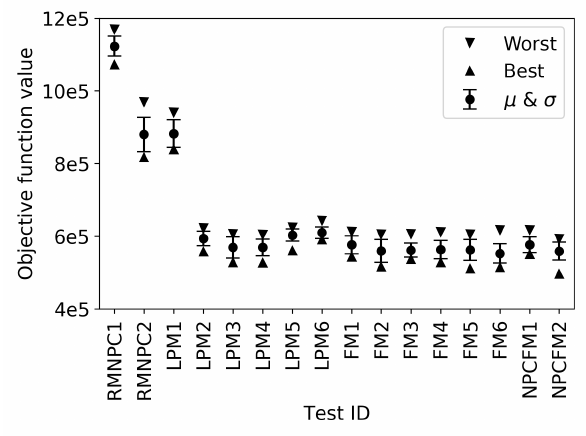
Figure 2. Overview of the obtained results for the different